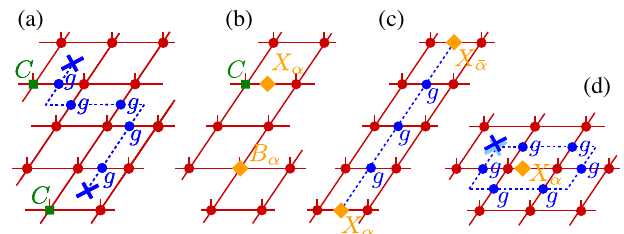
FIG. 1. (a) Strings of symmetry operations g ≡ V possibly dressed by trivially transforming end points C , form pairs of magnetic fluxes. (b) Objects which transform as non- trivial irreducible representations α under V excitations, such as site tensors B α , or matrices X α placed on links; again, they can be dressed with some trivially transforming tensor C . (c) A general pair of anyonic excitations, as used in this work to study anyon condensation and deconfinement. (d) Braid- ing as described in the language of entanglement symmetries (4) (see the